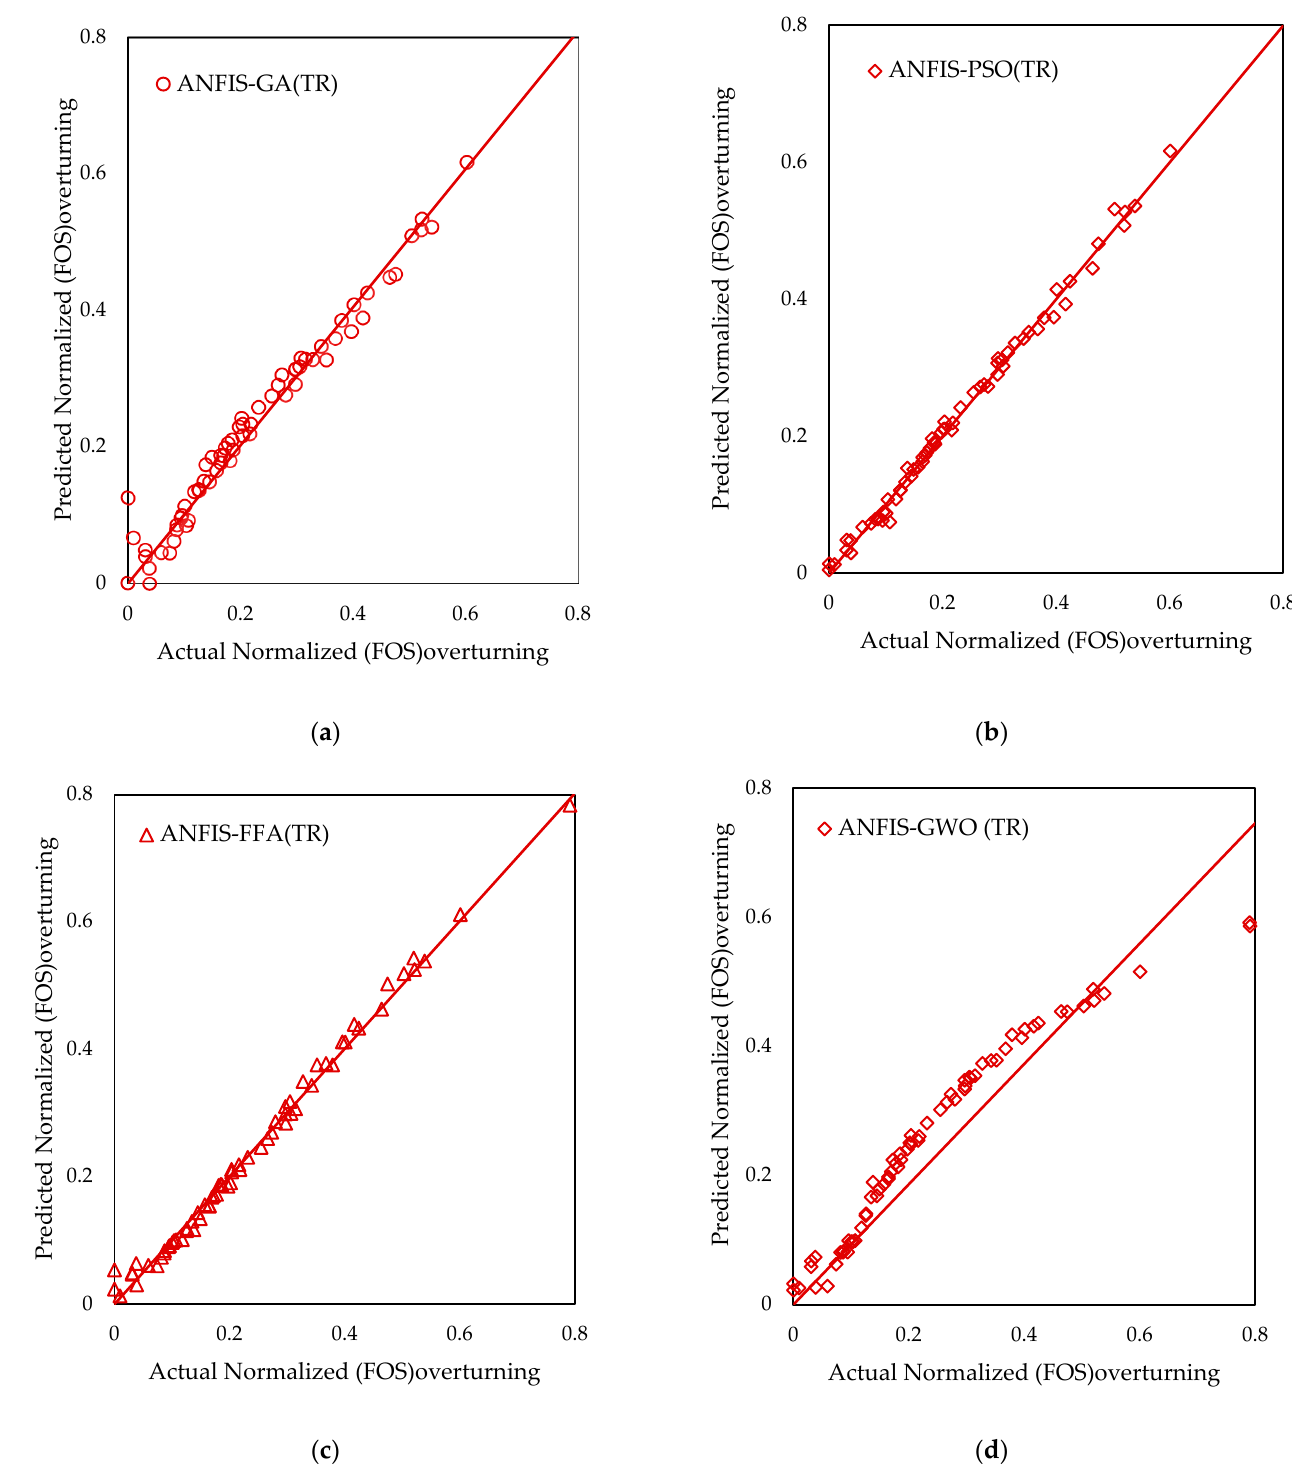
Figure 6. Plot of actual and predicted FOS of training data (TR) for ( a ) ANFIS − GA; ( b ) ANFIS − PSO; ( c ) ANFIS − FFA; and ( d ) ANFIS − GWO models.